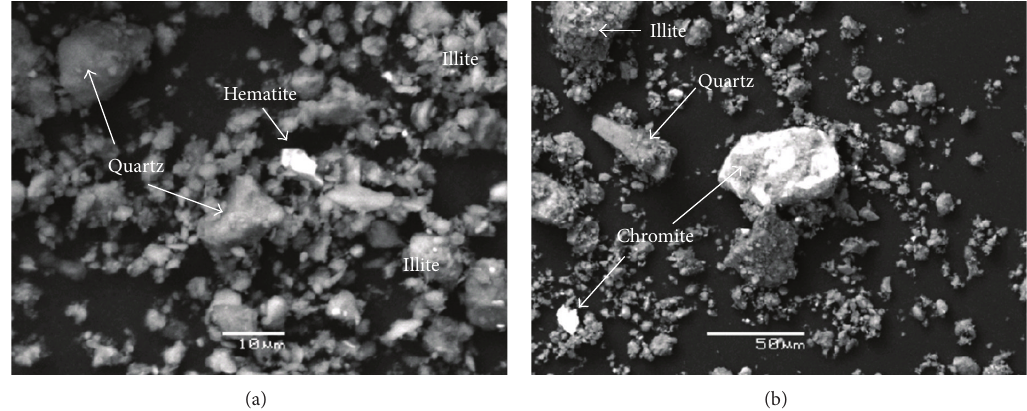
Figure5:SEMimagesofchromiferousironoreoccurrencesofOropos-Kalamosareashowing(a)hematite,illite,andquartzand(b)chromite, illite, and